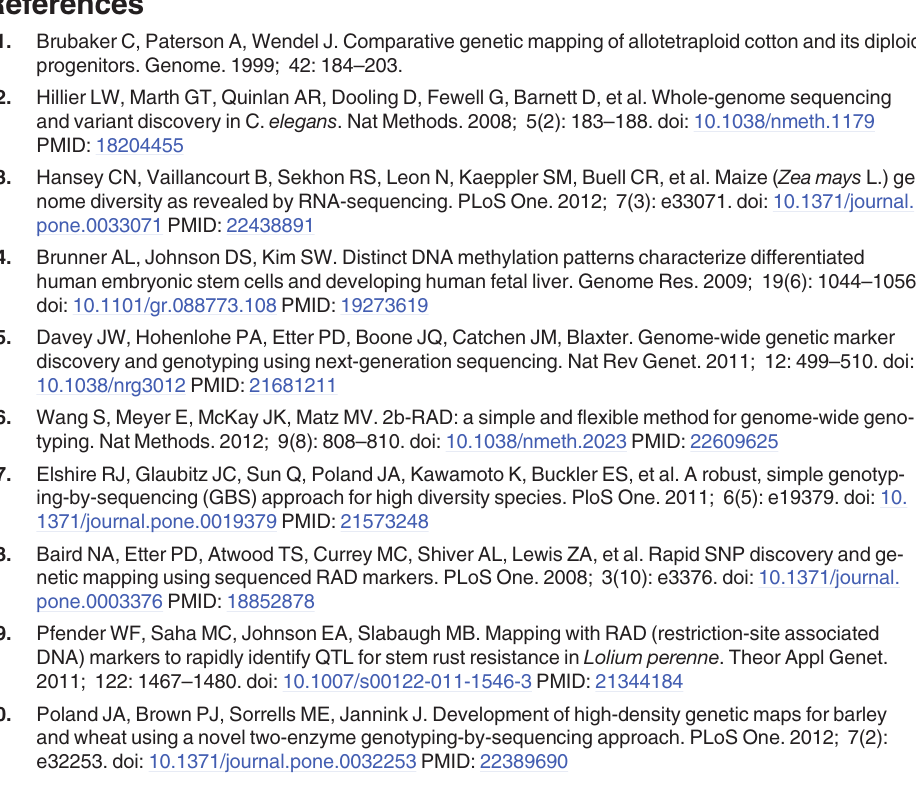
S1 Table. RAD marker information and genotypes. S2 Table. Genetic map